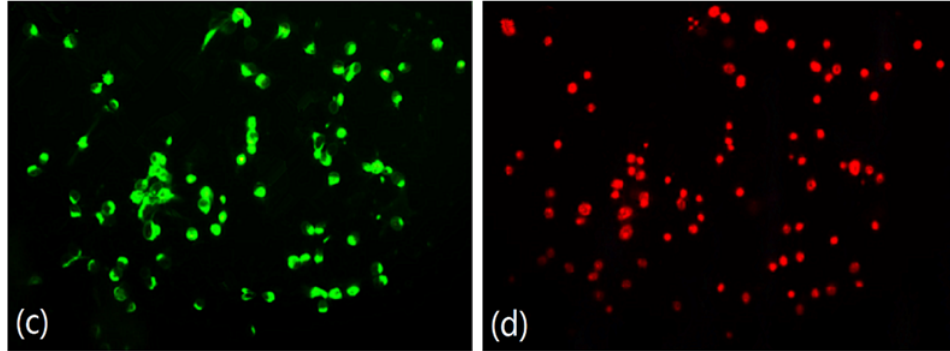
Figure 10. Fluorescent images of live/dead Salmonella : ( a , b ) Blank control group; ( c , d ) Treatment with CTS- g -P(AM-DMC).